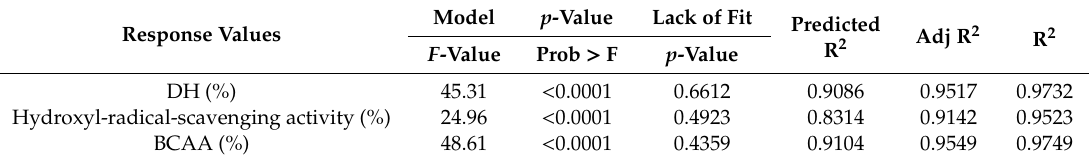
Table 3. ANOVA for response surface quadratic model.